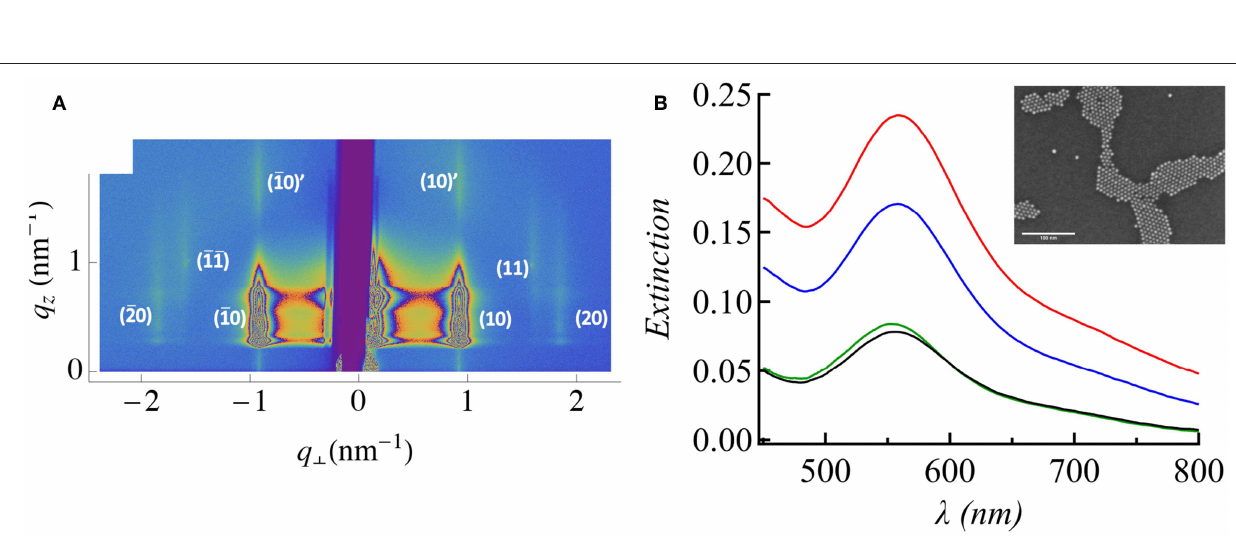
558 nm) = 558 nm, the hexagonal networks are large enough to be =